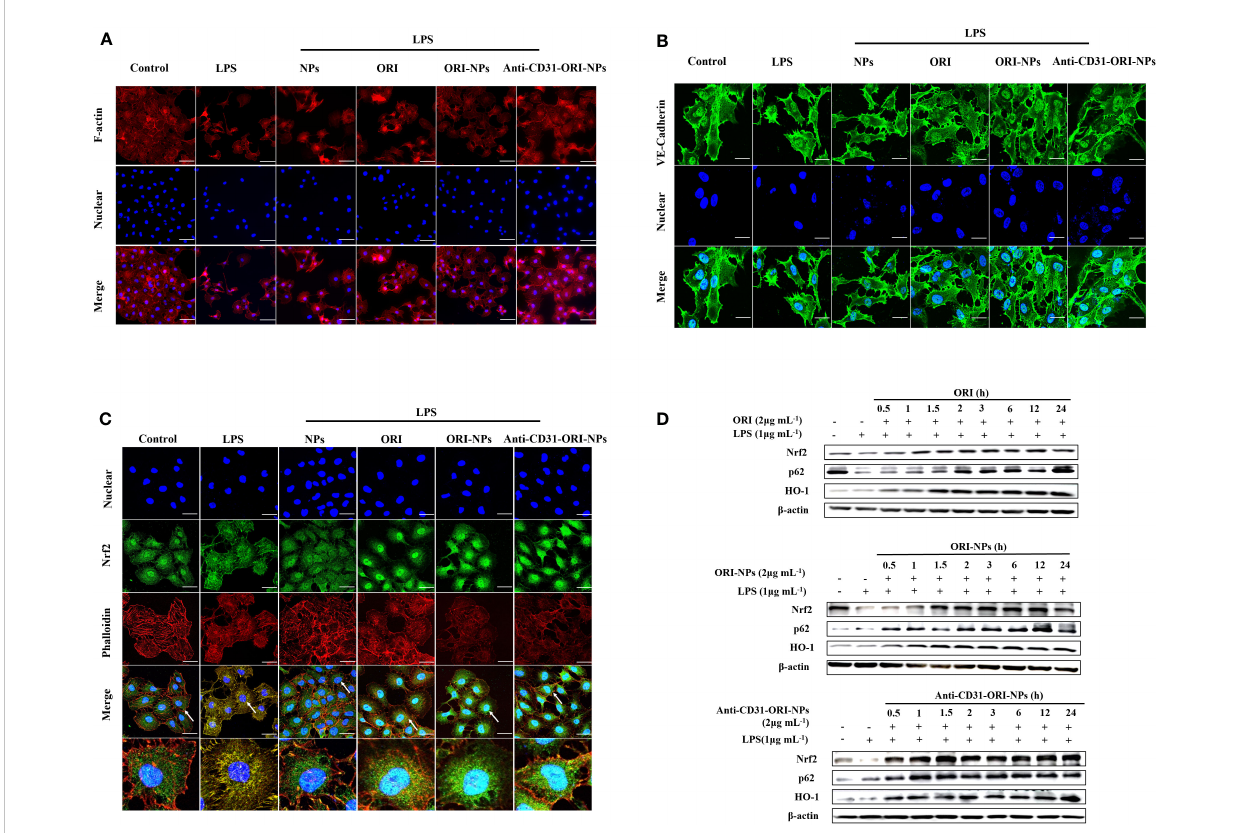
FIGURE 4 Anti-CD31-ORI-NPs recover LPS-induced endothelial injury (A, B) The effects of NPs, ORI, ORI-NPs and anti-CD31-ORI-NPs on cellular adhesion adjacent. After the pretreatment with 2 m g mL -1 NPs, ORI, ORI-NPs, anti-CD31-ORI-NPs, HUVECs were stimulated with 1 m g mL -1 LPS. The expression of F-actin and VE-Cadherin were analyzed by confocal fl uorescence microscopy. (C) The effects of NPs, ORI, ORI-NPs and anti-CD31- ORI-NPs on Nrf2 nuclear localization. After the pretreatment with 2 m g mL -1 NPs, ORI, ORI-NPs, anti-CD31-ORI-NPs, HUVECs were stimulated with 1 m g mL -1 LPS. Nrf2 expression were re fl ected under confocal fl uorescence microscopy. The arrow showed the Nrf2 accumulation. Bars: 50 m m. The nucleus was stained with DAPI (blue), and cytoskeleton was stained with phalloidin (red). F-actin, VE-Cadherin expression and Nrf2 localization